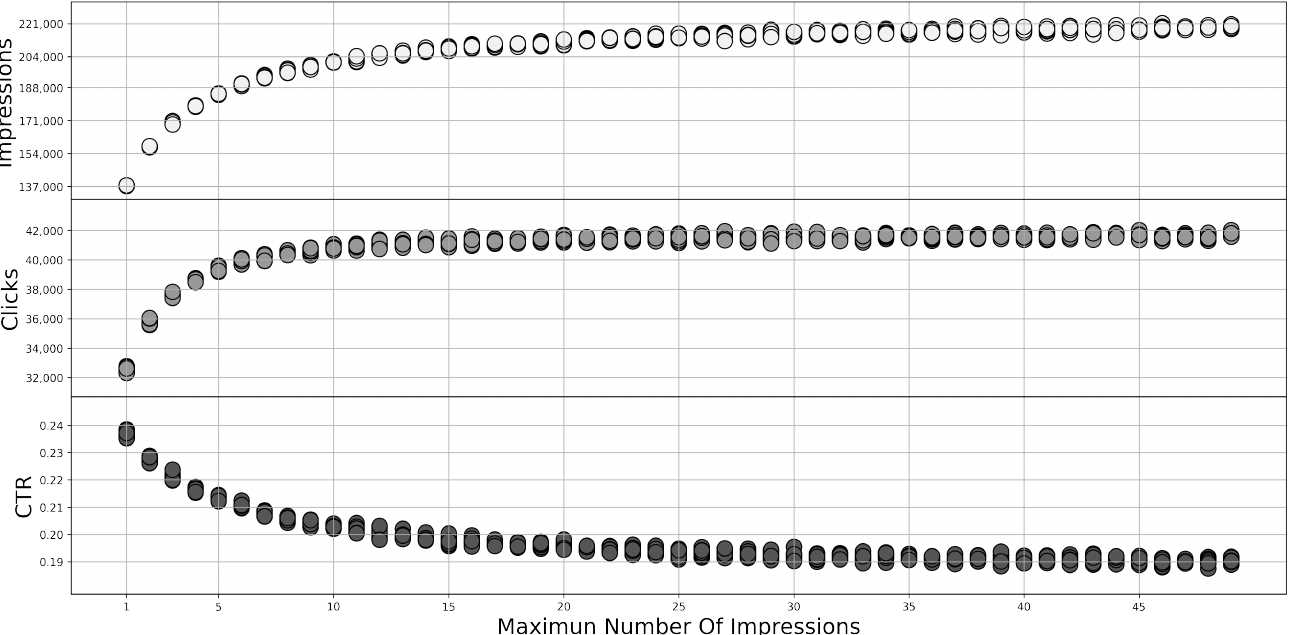
Figure 11. The figure shows the evolution of impressions, clicks and CTR for the simulated cases as we change the maximum impressions capping. All simulations are based on an audience of 100k